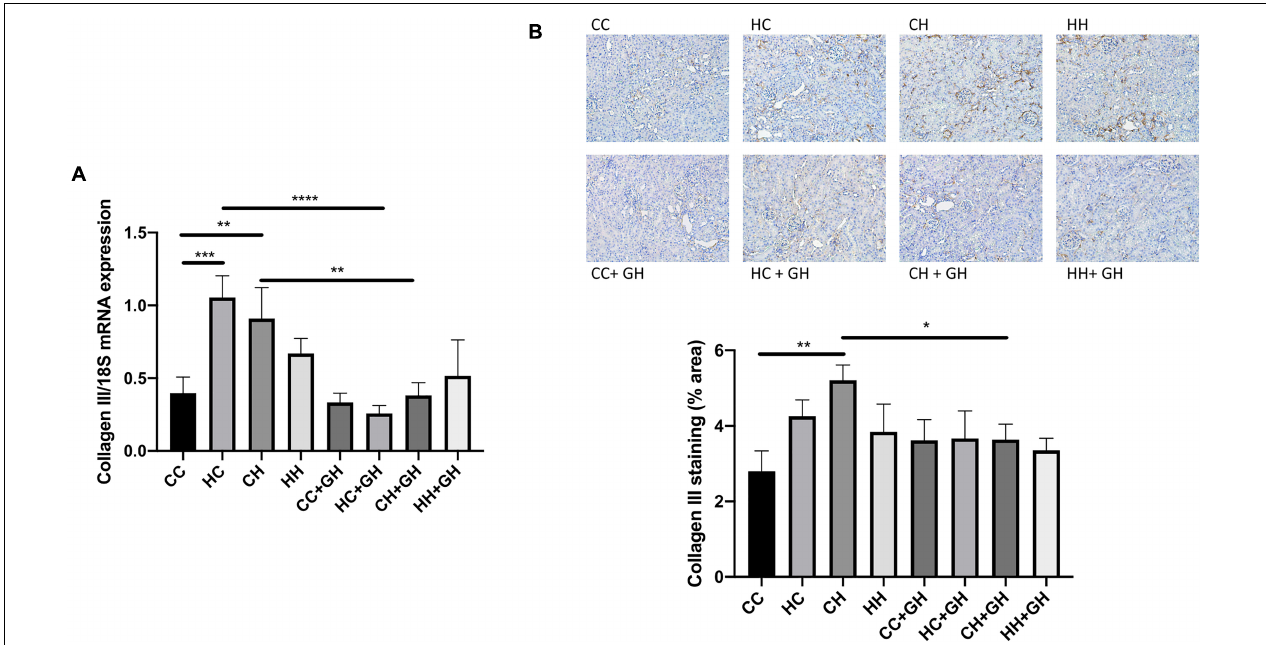
FIGURE 8 | Renal fibrotic changes as measured by collagen III. (A) mRNA expression of collagen III, (B) representative images of collagen III staining at 200 × magnification, and quantitation. Results expressed as mean ± SEM, n = 6. * p < 0.05, ** p < 0.01, *** p < 0.001, **** p < 0.0001. CC, control offspring; HC, lean offspring of obese mothers; CH, obese offspring of lean mothers; HH, obese offspring of obese mothers; CC + GH, control offspring exposed to gestational hydralazine; HC + GH, lean offspring of obese mothers with gestational hydralazine; CH + GH, obese offspring of lean mothers with gestational hydralazine; HH + GH, obese offspring of obese mothers with gestational hydralazine.